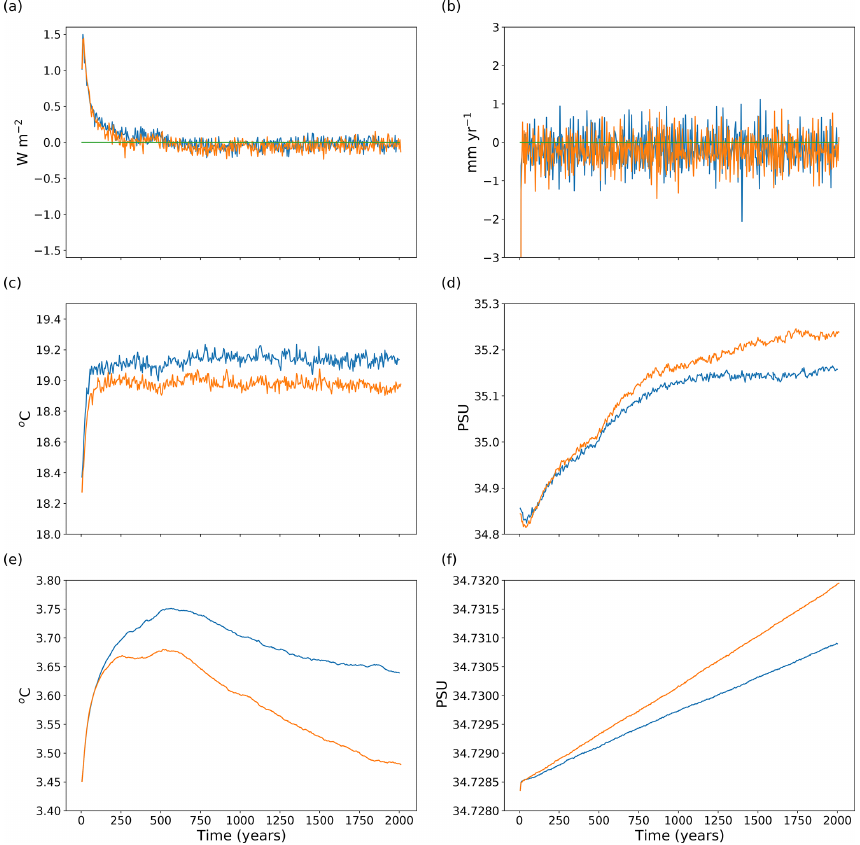
Figure 1. Time series of global mean (a) surface heat flux (Wm − 2 ) and (b) surface water flux (mmyr − 1 ) into the ocean, (c) SST ( ◦ C) and (d) SSS, and volume-averaged (e) potential temperature and (f) salinity. Cyan and orange lines show the quantities for the simulations run with the L35 and L20 configurations,